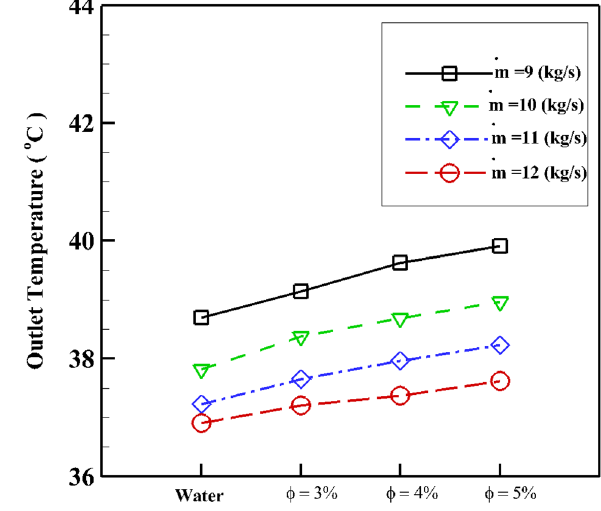
Fig. 16 Maximum temperature on WCP hot-side at constant con- centration vs flow rate